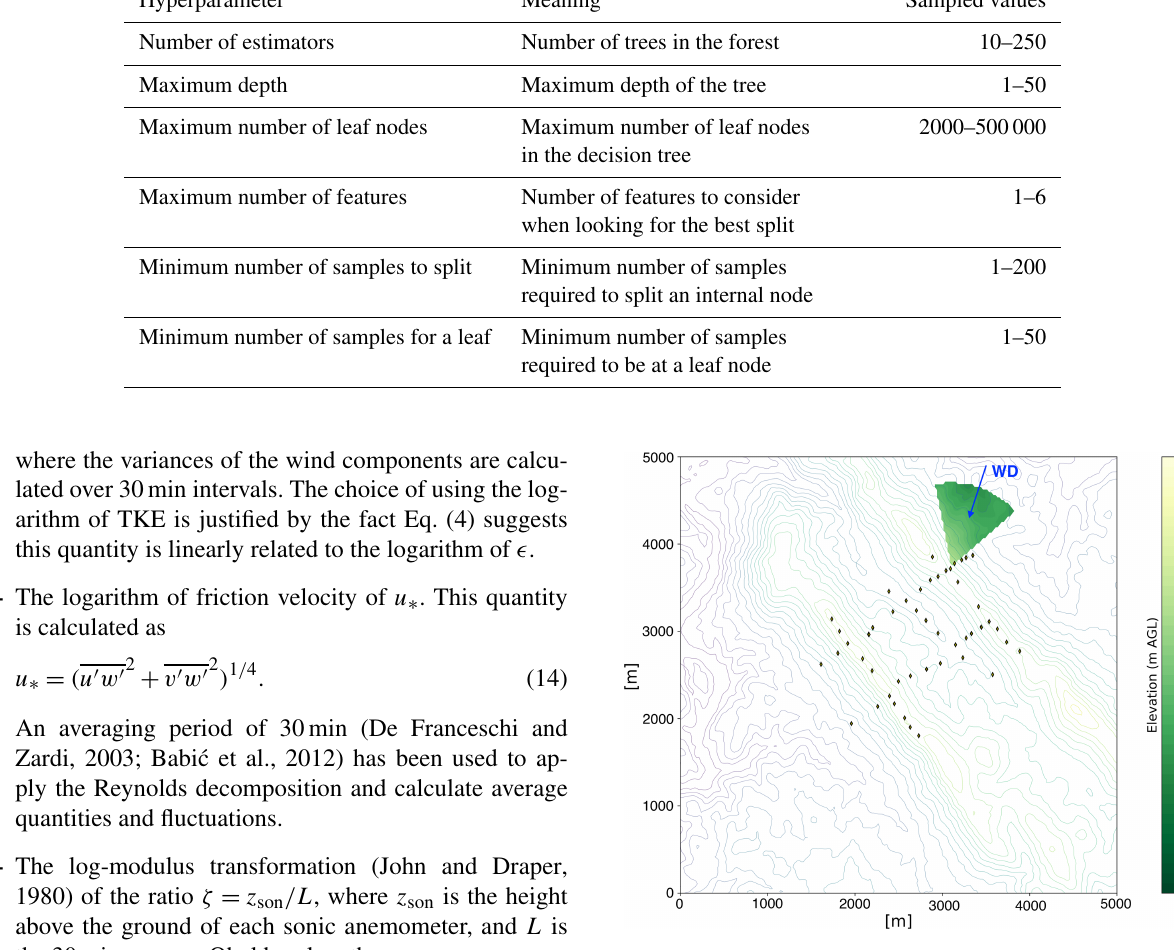
Figure 7. Example of an upwind terrain elevation sector with a 1km radius centered on the location of one of the meteorological towers at